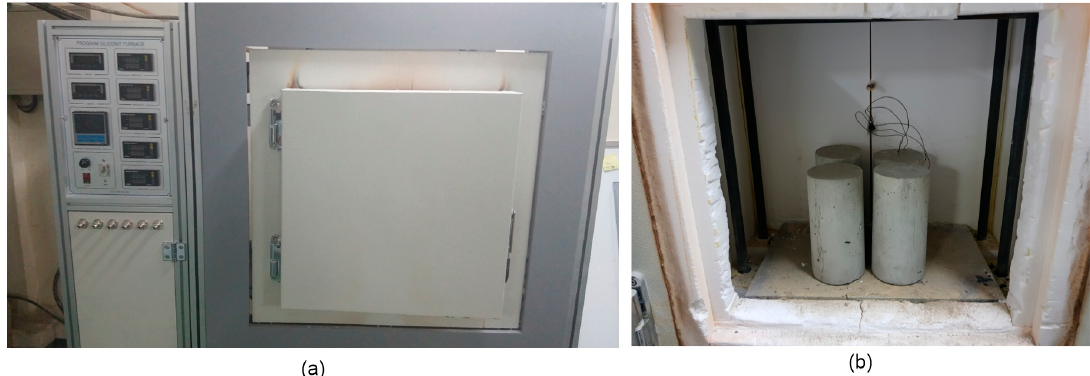
Figure 1. The electric furnace used for heating and cooling of concrete cylinders in this study: ( a ) a control unit and exterior view of the furnace, and ( b ) inside the furnace.